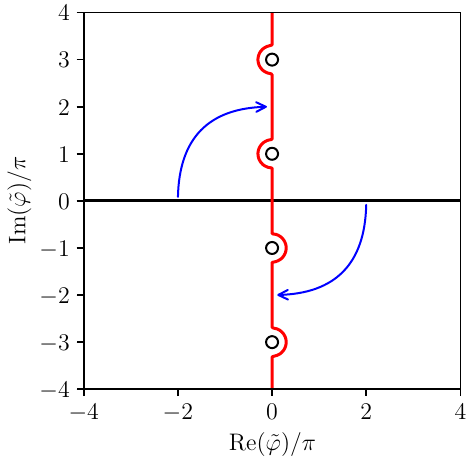
Figure 3 . The deformation of the contour of the fluctuation mode ˜ ϕ , from R (black line) to ( i − (cid:15) ) R (red curve), in order to analytically continue (3.22) as b 2 = | b 2 | e − i θ and θ increases from 0 to π . The empty dots are the branch cut singularities of S